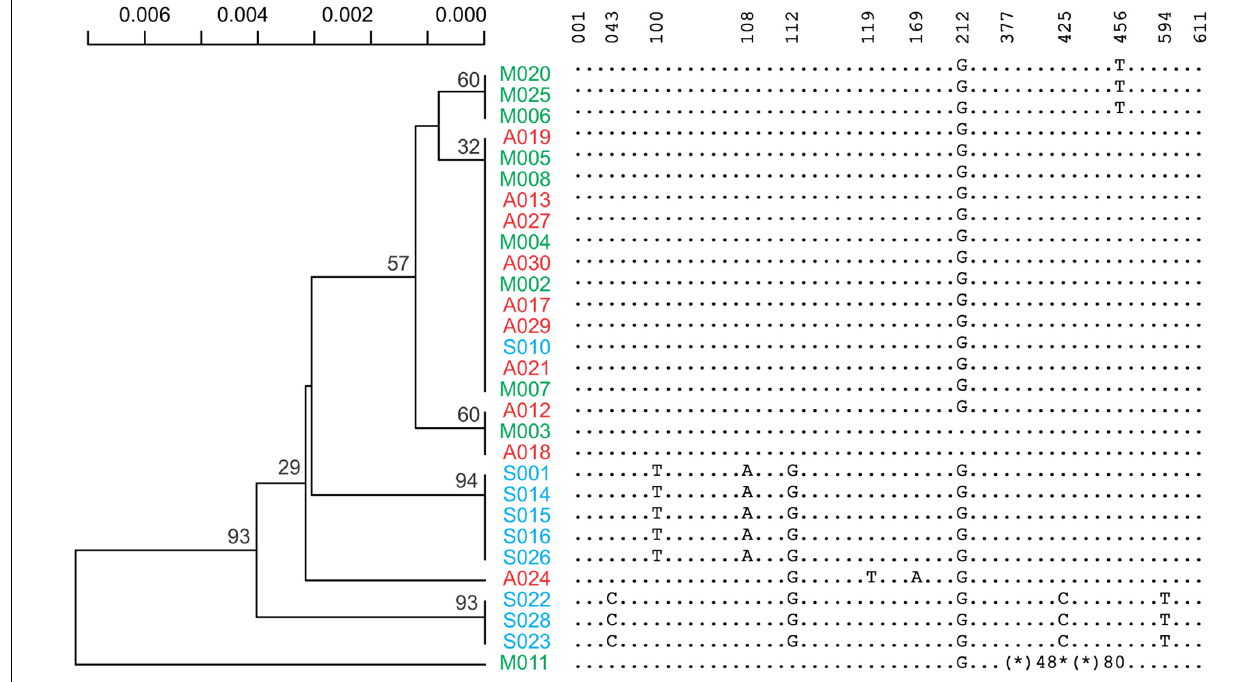
FIGURE 3 | A maximum likelihood phylogenetic tree inferred from ITS1-5.8S-ITS2 part of rDNA sequences. Reduced form of the sequences covering all the variants and their locations has also been presented. An asterisk indicates deletion and an asterisk followed by a number indicates the number of deleted residues.